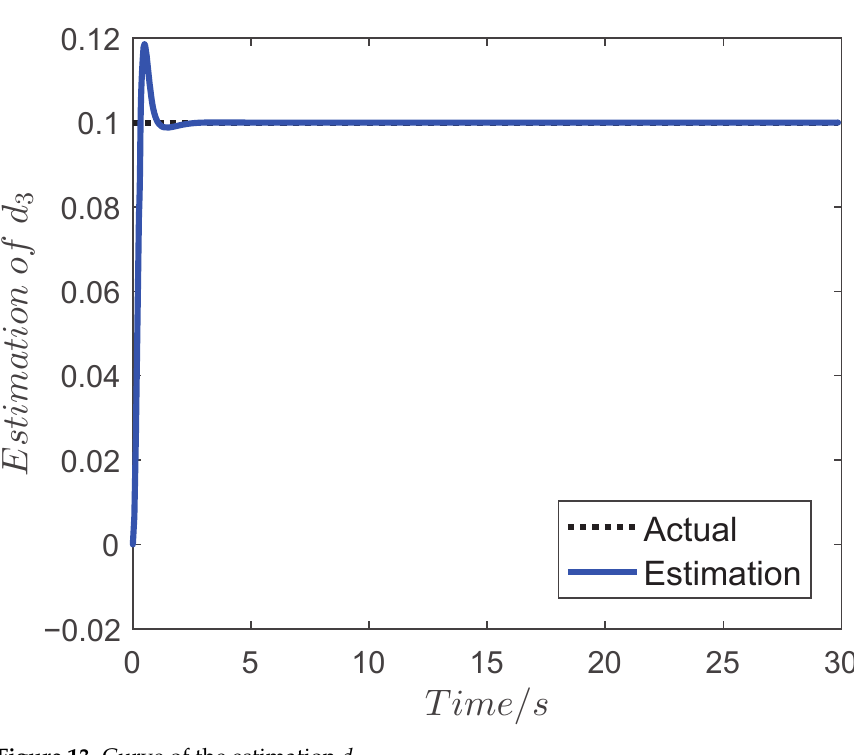
Figure 13. Curve of the estimation d 3